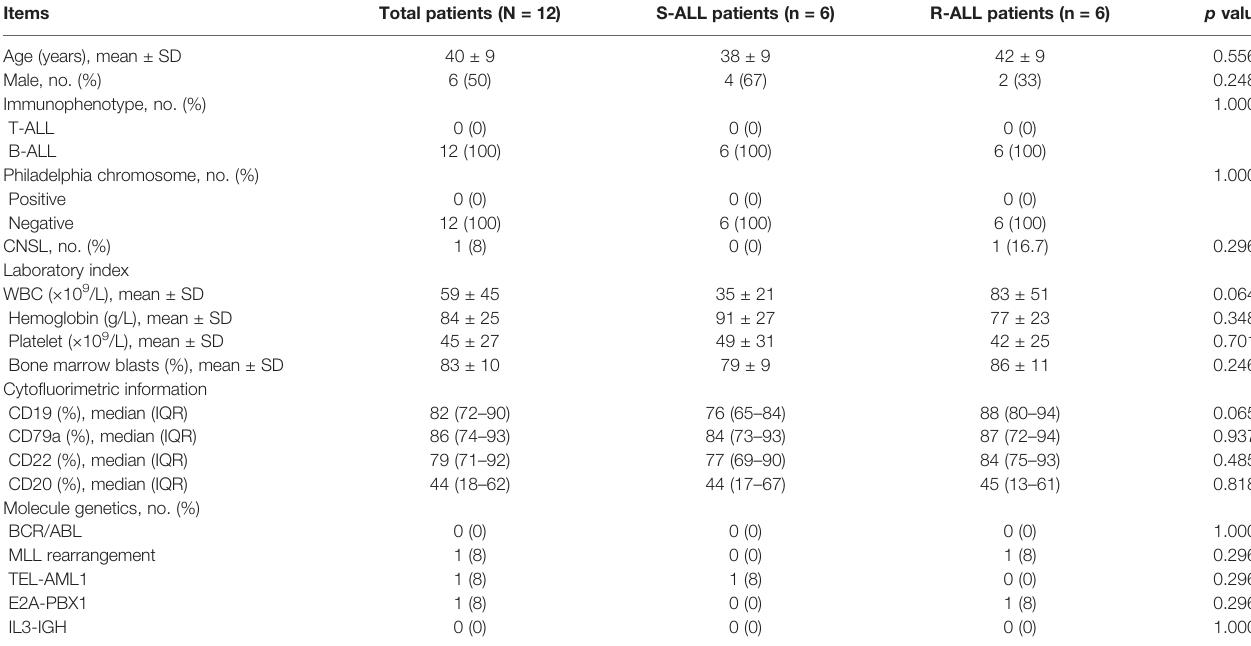
TABLE 1 | Clinical characteristics of B-ALL